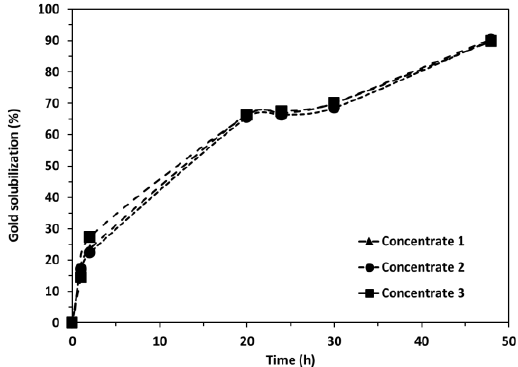
Figure 5. Dissolution kinetic of gold by cyanidation of the concentrates treated by the bacterial oxidation process.